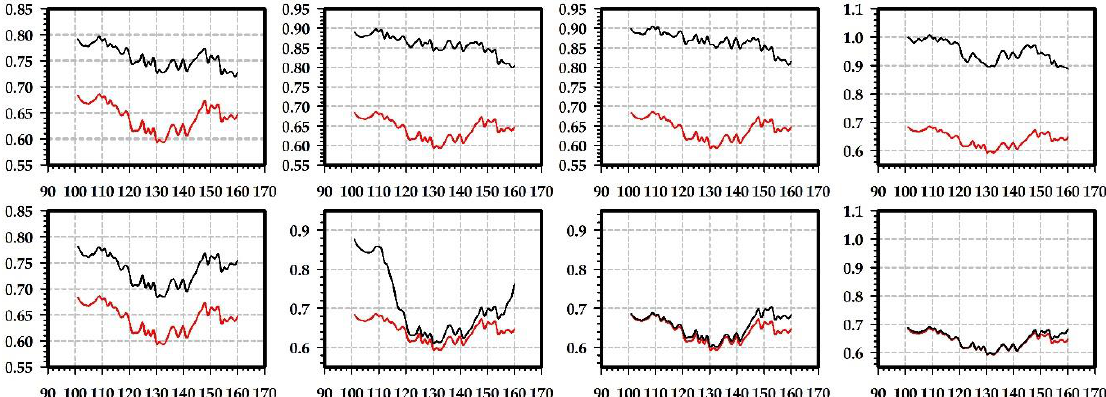
Figure 9. Illustration of generated highlight intensity distribution for the selected column of pixels with the marble material. First row: highlight effects generated by our Ward-based method, where images from left to right correspond to images of the first row in Figure 3; second row: highlight effects generated by the method based on the traditional Ward model, where images from left to right correspond to images of the second row in Figure 3 and the n t , n b parameters are n t is 2, n b is 2; n t is 2, n b is 10; n t is 10, n b is 2; n t is 10, n b is 10. In each image, the x axis is the vertical coordinate position of a pixel in the selected line and the y axis is the intensity value of the pixel.